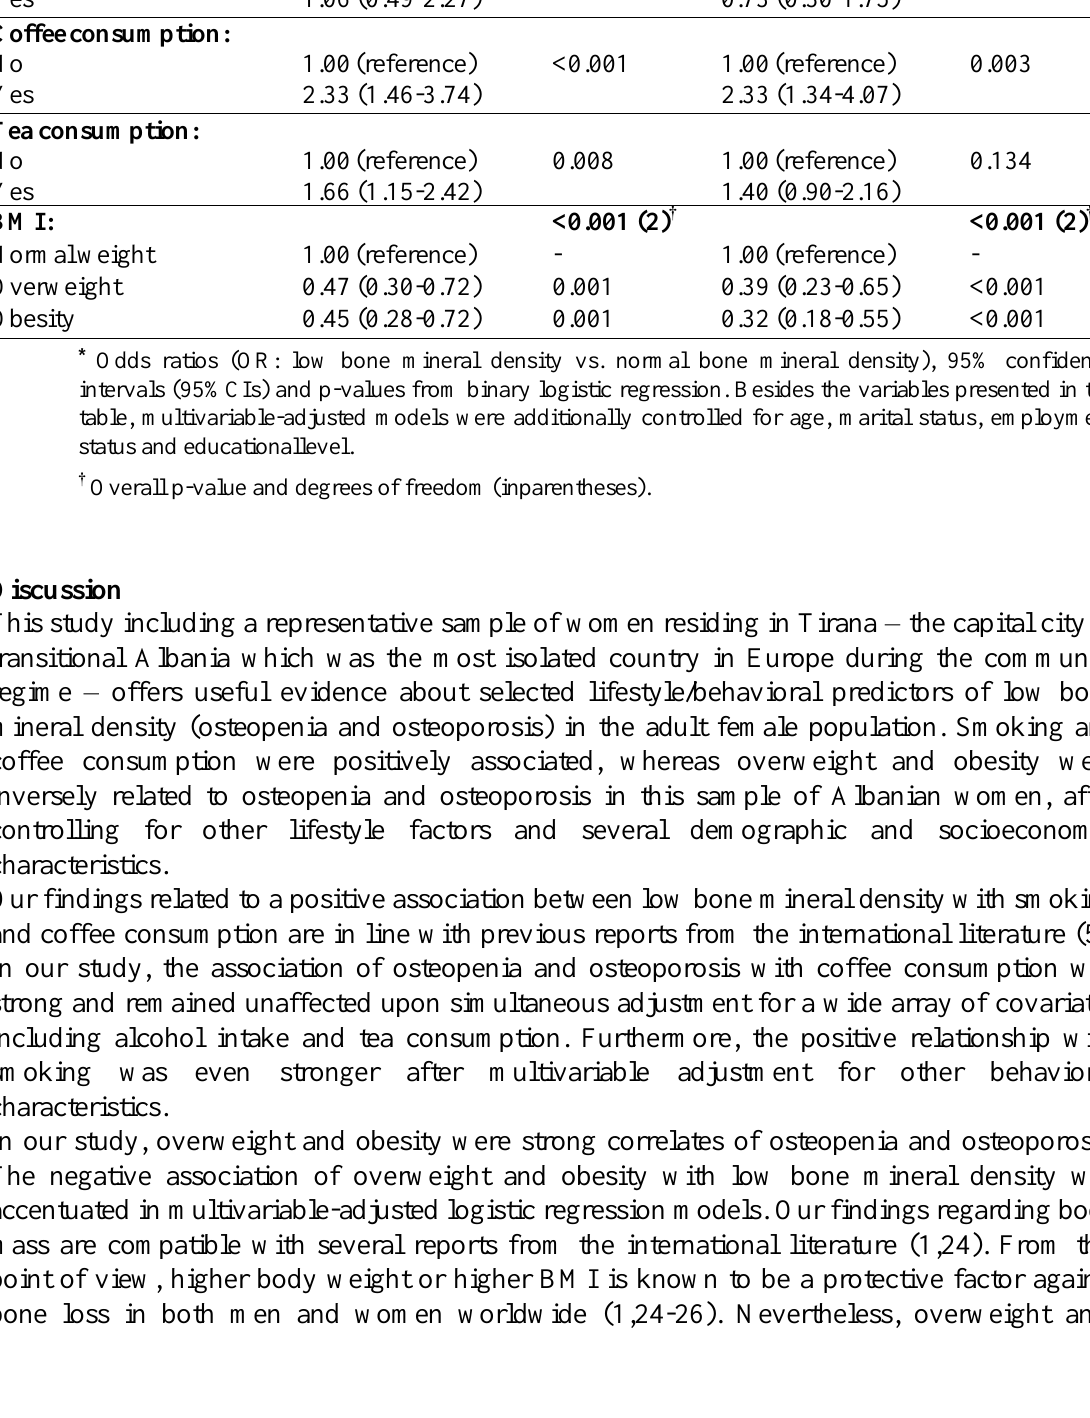
Table 2. Association of low bone mineral density with lifestyle/behavioral factorsamong women in Tirana, Albania Variable